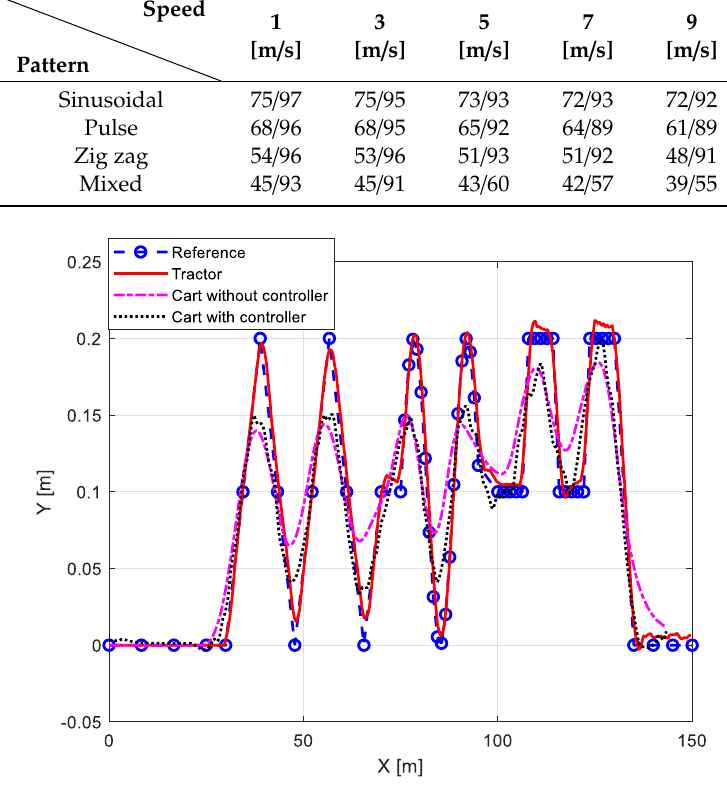
Figure 16. Performance of tractor-cart position control system under a Mixed pattern in 9 [m / s]. Table 7. Comparison of previous studies and present The accuracy of the controller in finding the right path was calculated. The chosen range for the x -axis was −10 cm to 10 cm and −1 cm to 1 cm for the y -axis. Any reading beyond these ranges was not counted as an accurate reading (Table 6). Table 6. Coverage percent (without controller/with controller) .